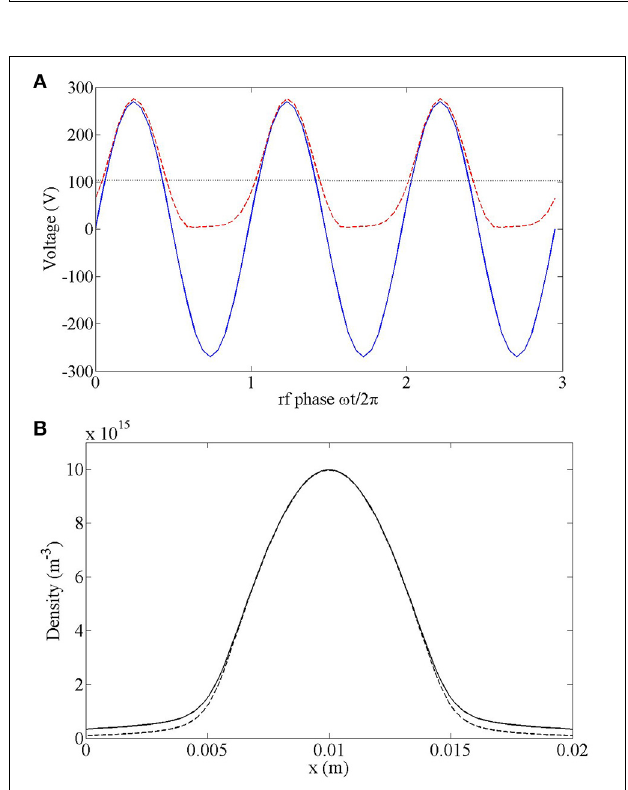
FIGURE 3 | CFD simulation results for a 1D parallel plate CCP over three rf periods showing (A) phase resolved electrode voltage (blue solid line), phase resolved plasma potential at the central point (x = 10 mm) (red dashed line) and phase averaged plasma potential at the central point (x = 10 mm) (black dotted line) and (B) phase averaged ion (solid line) and electron (dashed line) density.